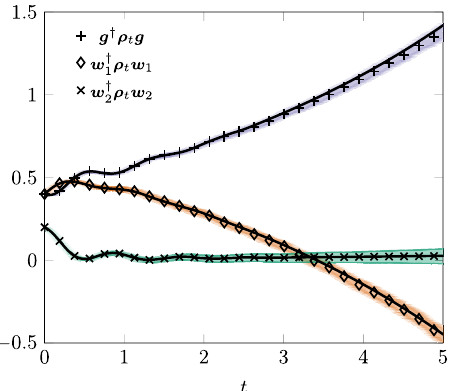
Fig. 4 Illustration of the in fl uence martingale for a Red fi eld equation. The parameters for the model (20) are γ 1 = 1, γ 2 = 4, α = 3 and κ = 1. The initial ffiffiffiffiffiffiffi p ¼ 0 : 2 condition is ψ 0 state, w 1 ¼ L y g and w 2 ¼ L y g . The crosses, diamonds, and x's show the 1 2 result from Monte Carlo simulations after 10 4 realizations. The full lines are master equation predictions and the shaded regions have the same meaning as in Fig. 2. The time mesh is d t = 0.0125. The diamonds show that ρ t is non positive de fi nite for t > 3.